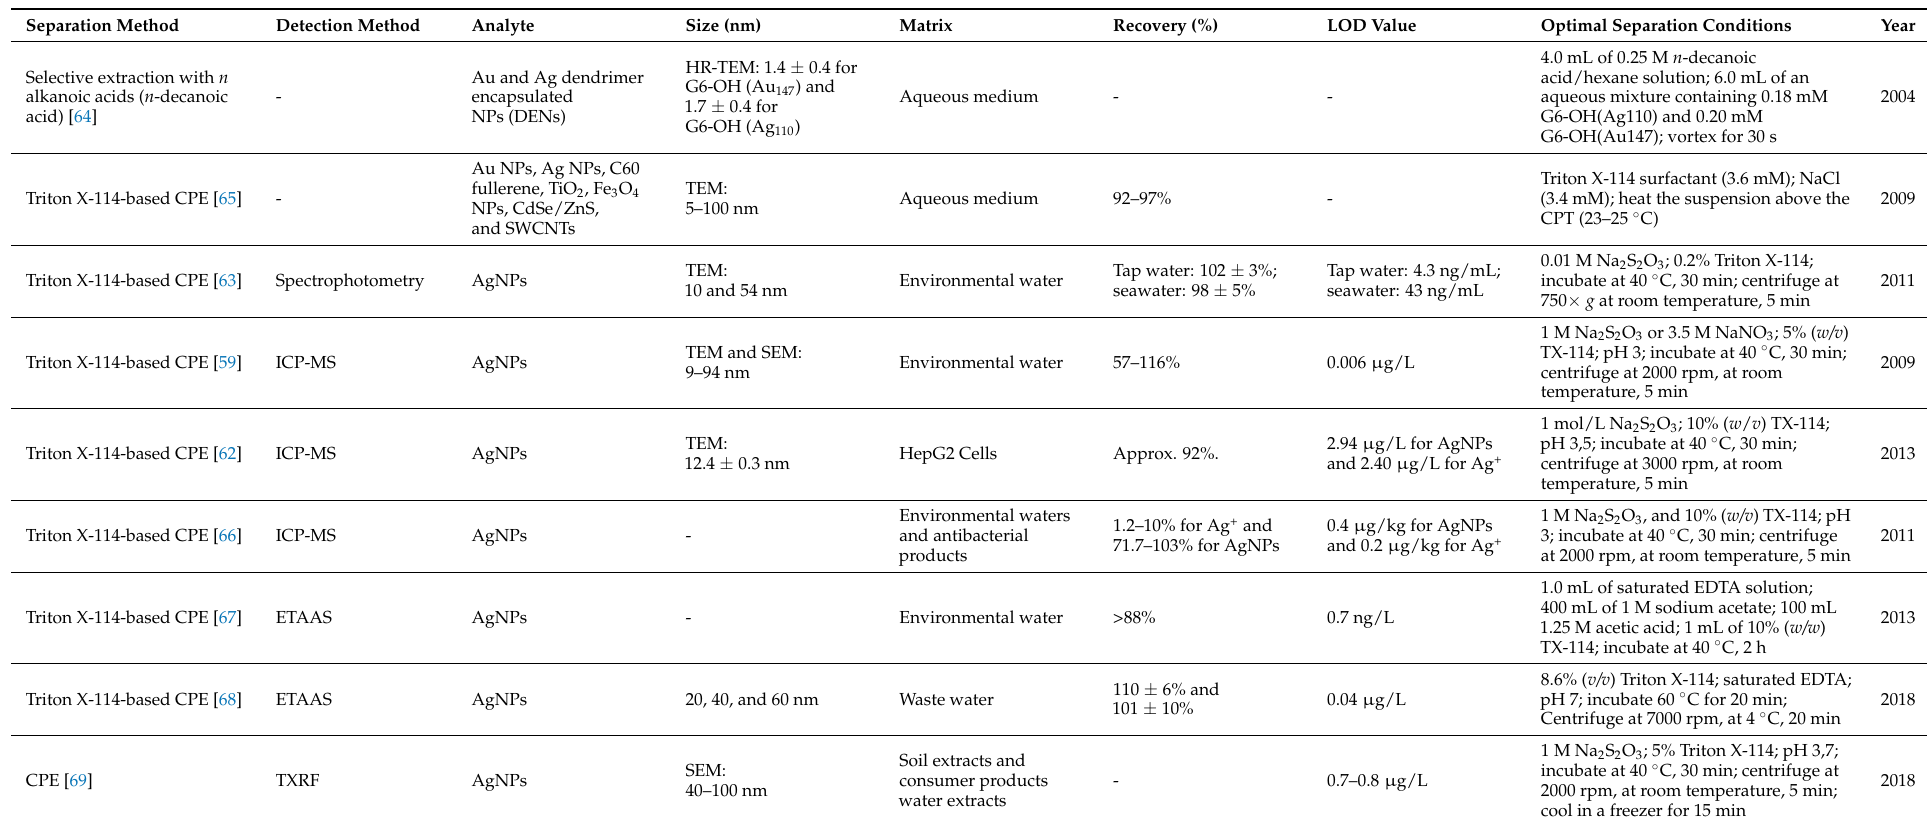
Table 7. Overview of the AgNPs separation by liquid extraction